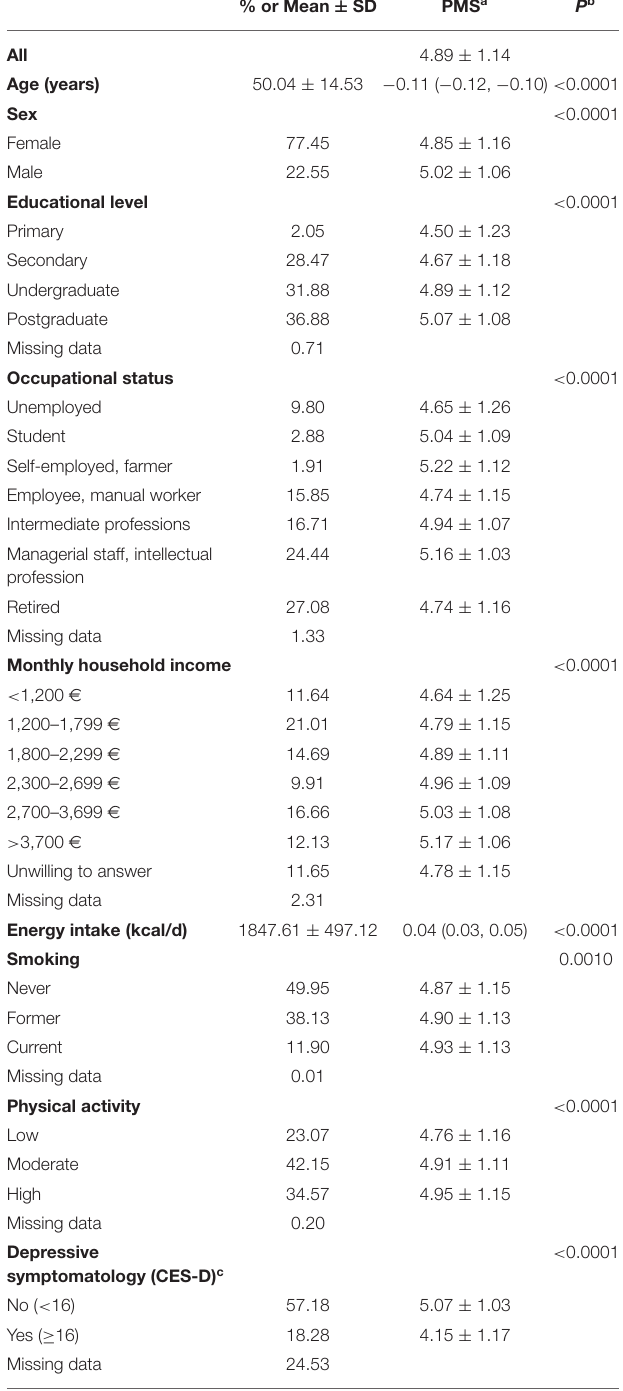
TABLE 1 | Individual characteristics of N = 32,588 participants (NutriNet-Santé cohort study,